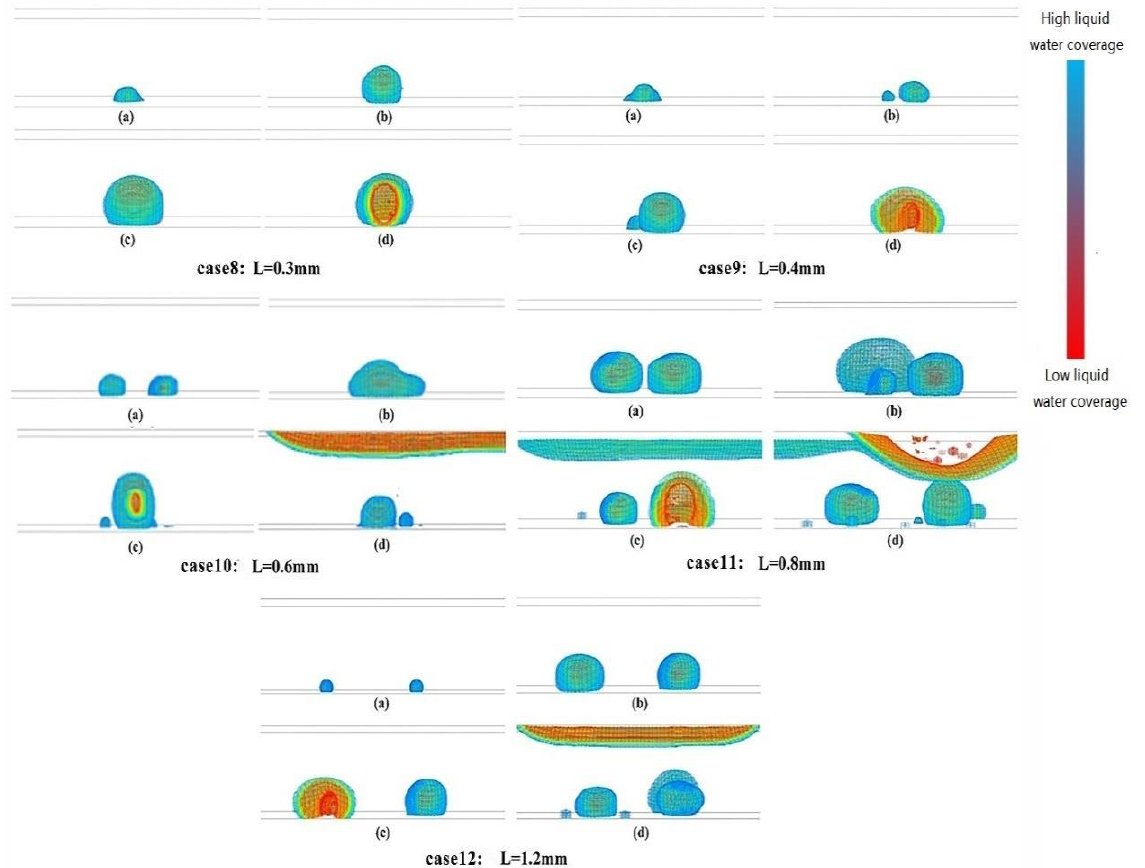
Figure 8. Effect of the pore distance on the morphology of two droplets. Case8–9: ( a )Fusion of droplets, ( b , c ) Continuous growth of droplets, ( d ) Breaking of droplets; case10: ( a ) Appearance of droplets, ( b ) Fusion of droplets, ( c ) Fragmentation of fusion droplets, ( d ) Fusion of new droplets; case11–12: ( a – c ) Upstream and downstream droplets grow and break separately, ( d ) Emergence and fusion of new droplets) .